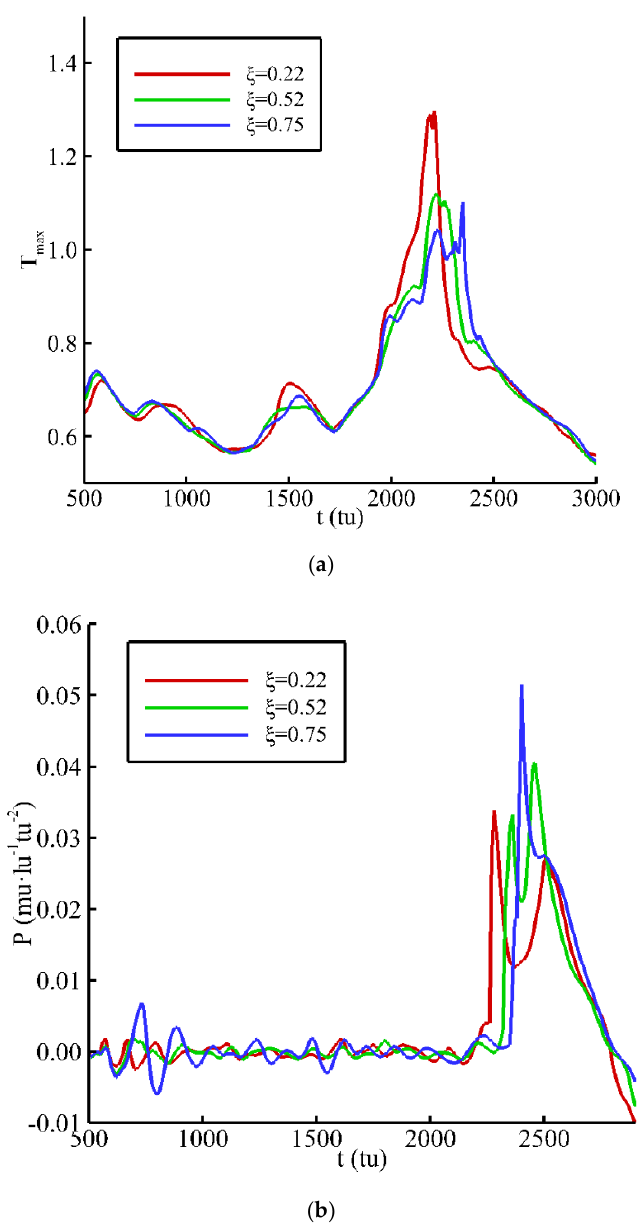
Figure 12. The evolution of the max temperature inside the bubble and the pressure at the center of the convex wall in the growth and collapse process of the cavitation bubble. ( a ) The max temperature inside the bubble; ( b ) the evolution of the pressure at the center of the convex wall.